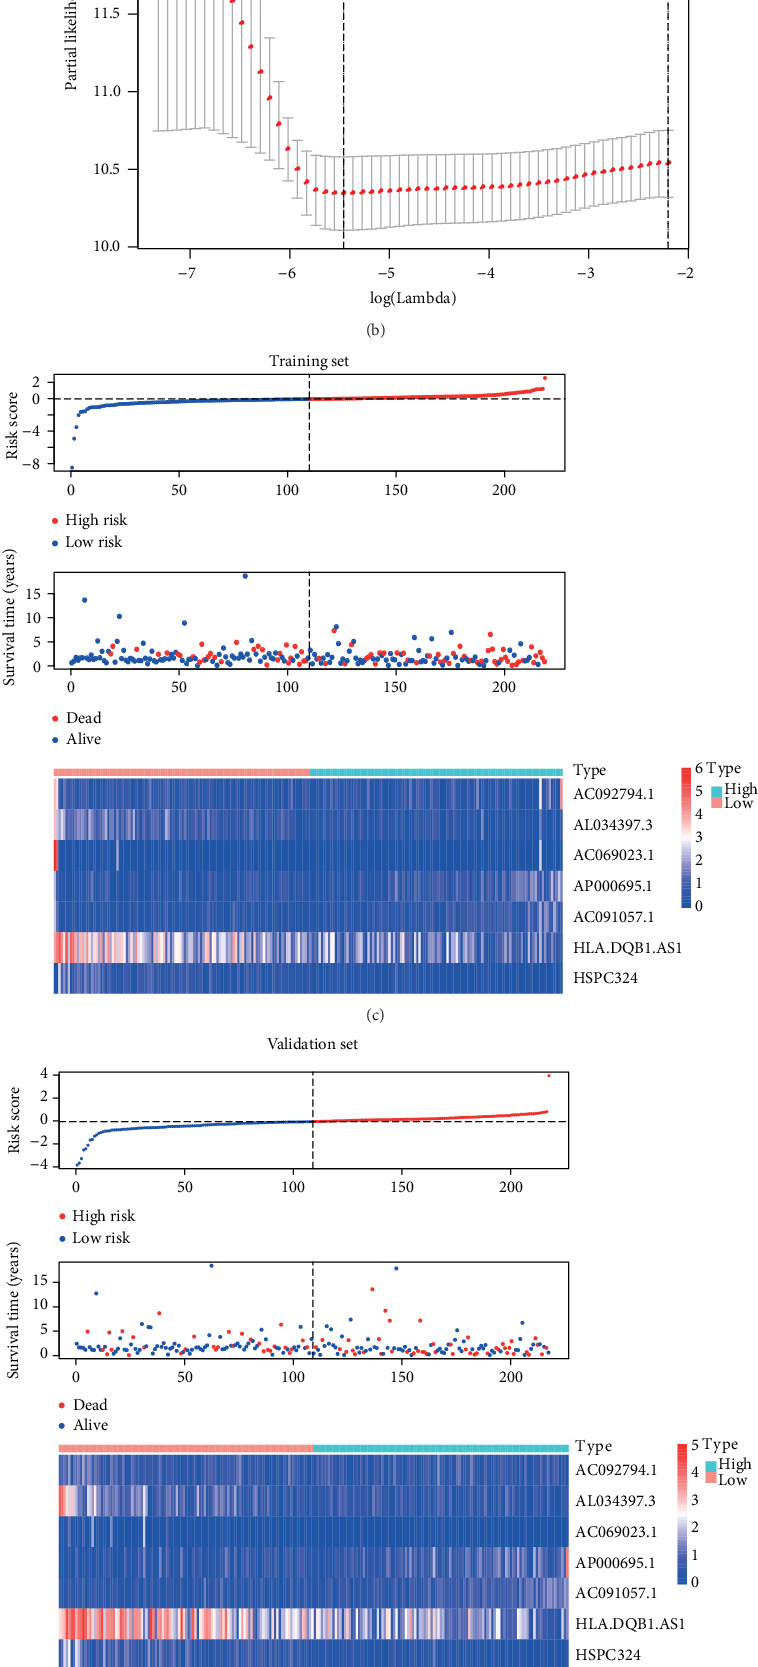
(a, b) The figures of LASSO coefficient distribution and partial likelihood deviation of the LASSO coefficient distribution of the training set. (c–e) Risk plots of the three sets. In each set, the risk score distribution, patients' survival status, and gene expression in the low- and high-risk groups were displayed. LASSO: least absolute shrinkage and selection operator.